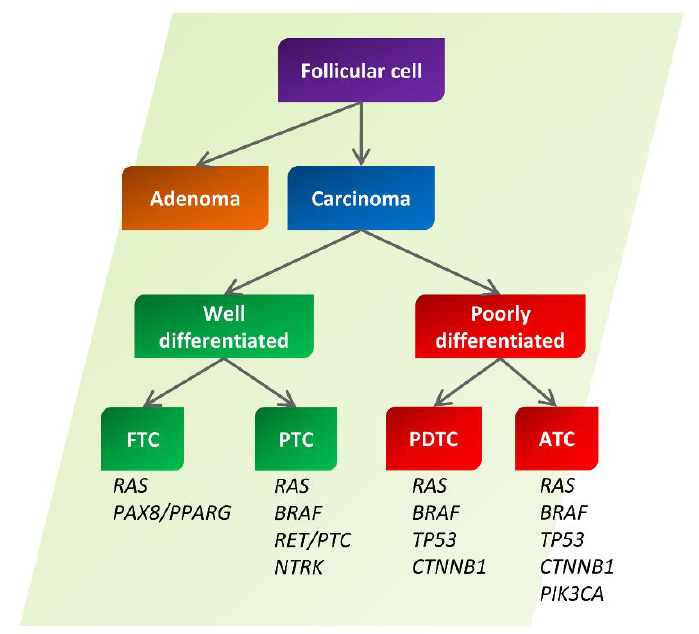
Figure 1. Tumors generated from human thyroid follicular cells. Schematic representation of the mainly benign and malignant tumors generated from human thyroid follicular cells. Several mu- tations frequently encountered in each tumor histotype are also indicated. FTC, follicular thyroid carcinoma; PTC, papillary thyroid carcinoma; PDTC, poorly differentiated thyroid carcinoma; ATC, anaplastic thyroid carcinoma.